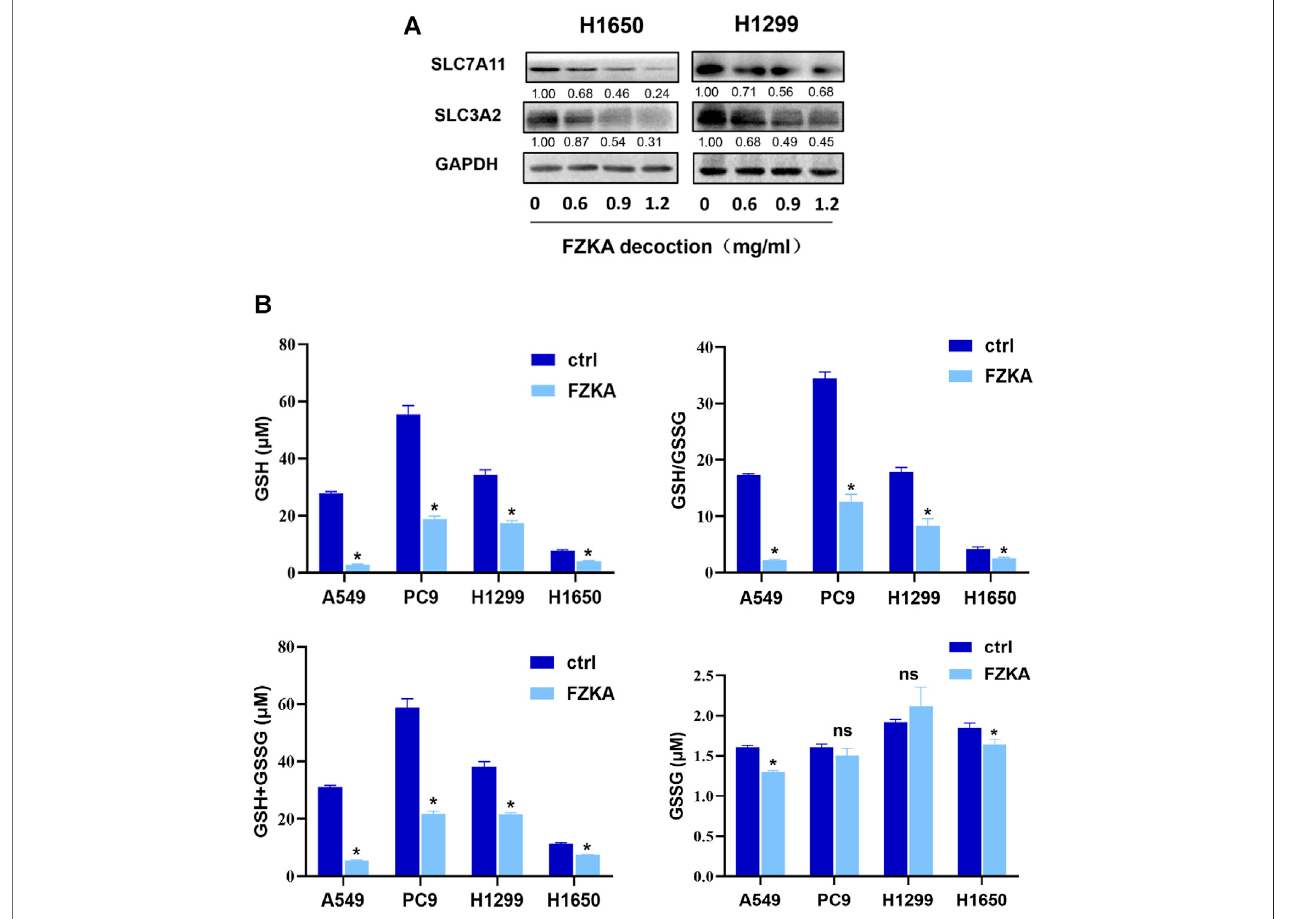
FIGURE 5 | FZKA decreased the ratio of GSH/GSSG and expression of system xc − . (A) , The protein expression levels of SLC7A11 and SLC3A2 were detected by Western blot. (B) , the levels of GSH and GSSG were measured by GSH and GSSG Assay kit. Each point represents the mean ± SEM, n = 3. * p <